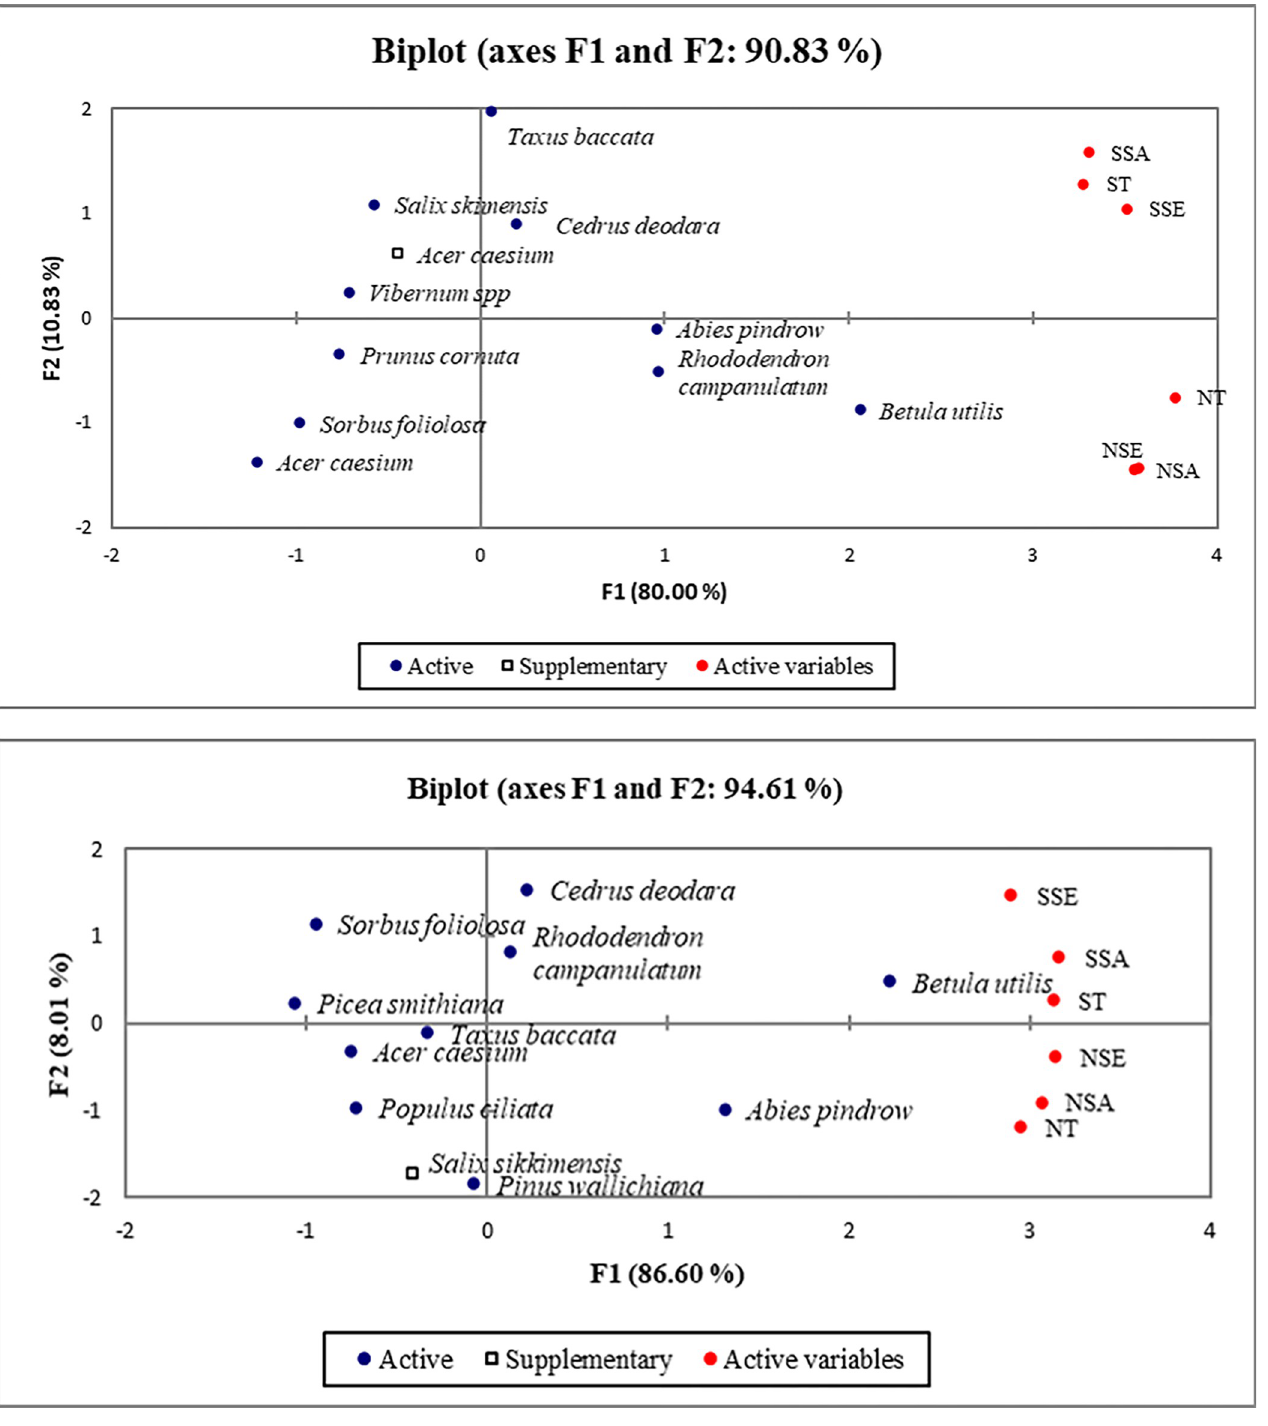
Fig 2. Principle component analysis (PCA) on the basis of frequency quality indicator at BG and TLR sites.